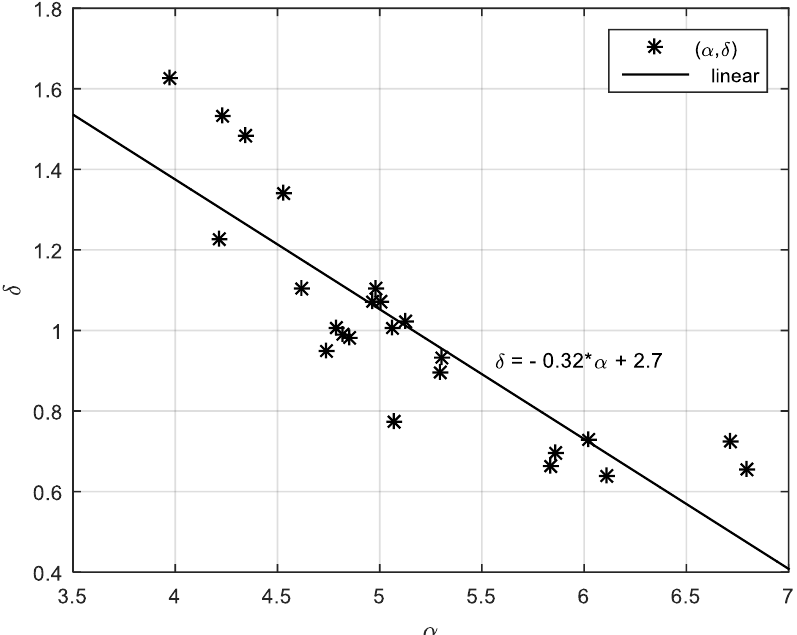
Figure 7. Linear correlation between the model parameters 𝛼 and 𝛿 .